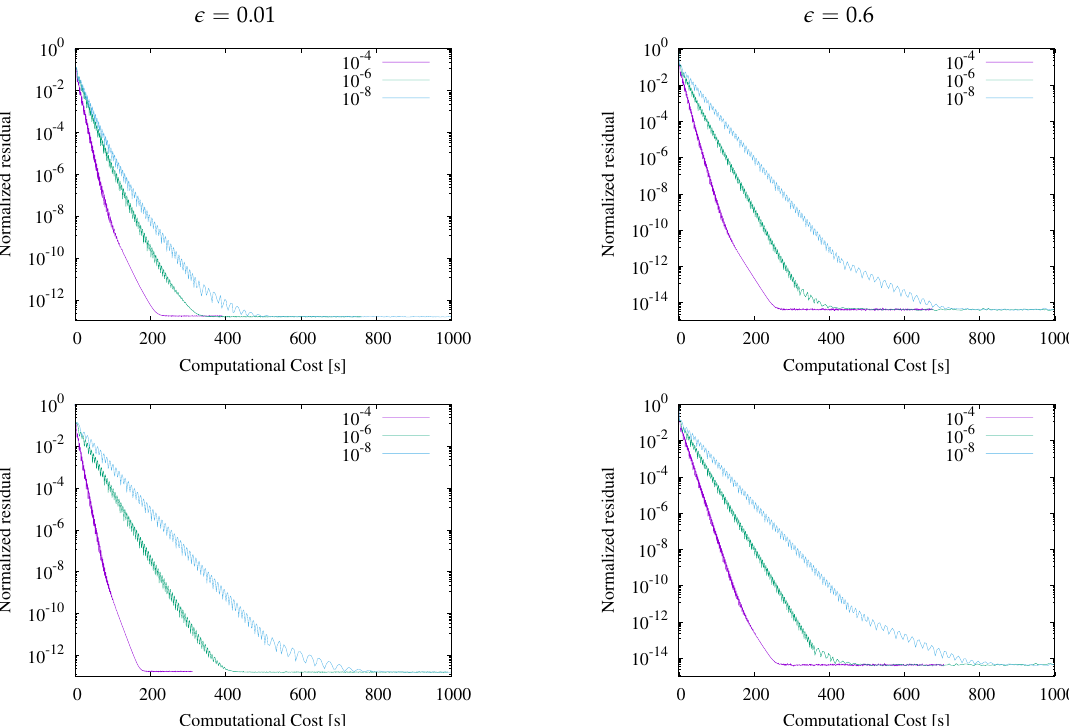
Figure 5. Buoyancy-driven square cavity. Residual convergence for GMRES tolerances for the Boussinesq